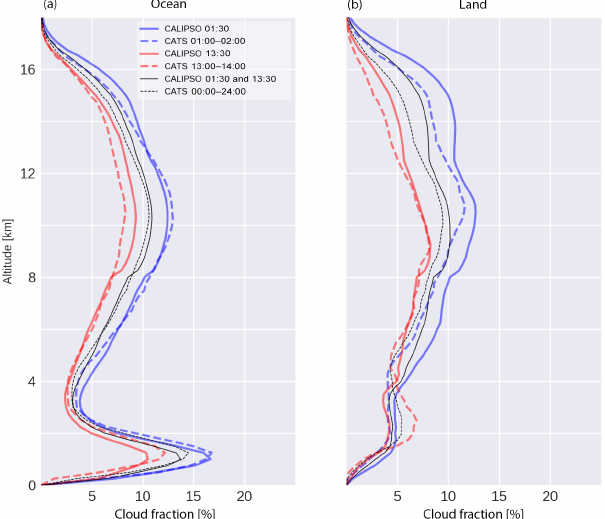
Figure 7. Vertical profiles of cloud fraction observed by CALIPSO (full line) and CATS (dashed line) between ± 51 ◦ around 01:30 (blue), 13:30 (red), and at all times (black), over ocean (a) and land (b) . Measurements were weighted based on the latitude at which they were made to account for the different zonal sam- pling distributions of both instruments. CALIOP cloud profiles were built using cloud layers from the CALIPSO v4.10 level 2, 5km cloud layer product. Only layers with a cloud–aerosol discrimina- tion score (CAD_Score) above 0.7 were considered to build the CALIOP profiles, and layers with a Feature_Type_Score above 5 were considered to build the CATS profiles. For both instruments, we used JJA observations from 2015 to